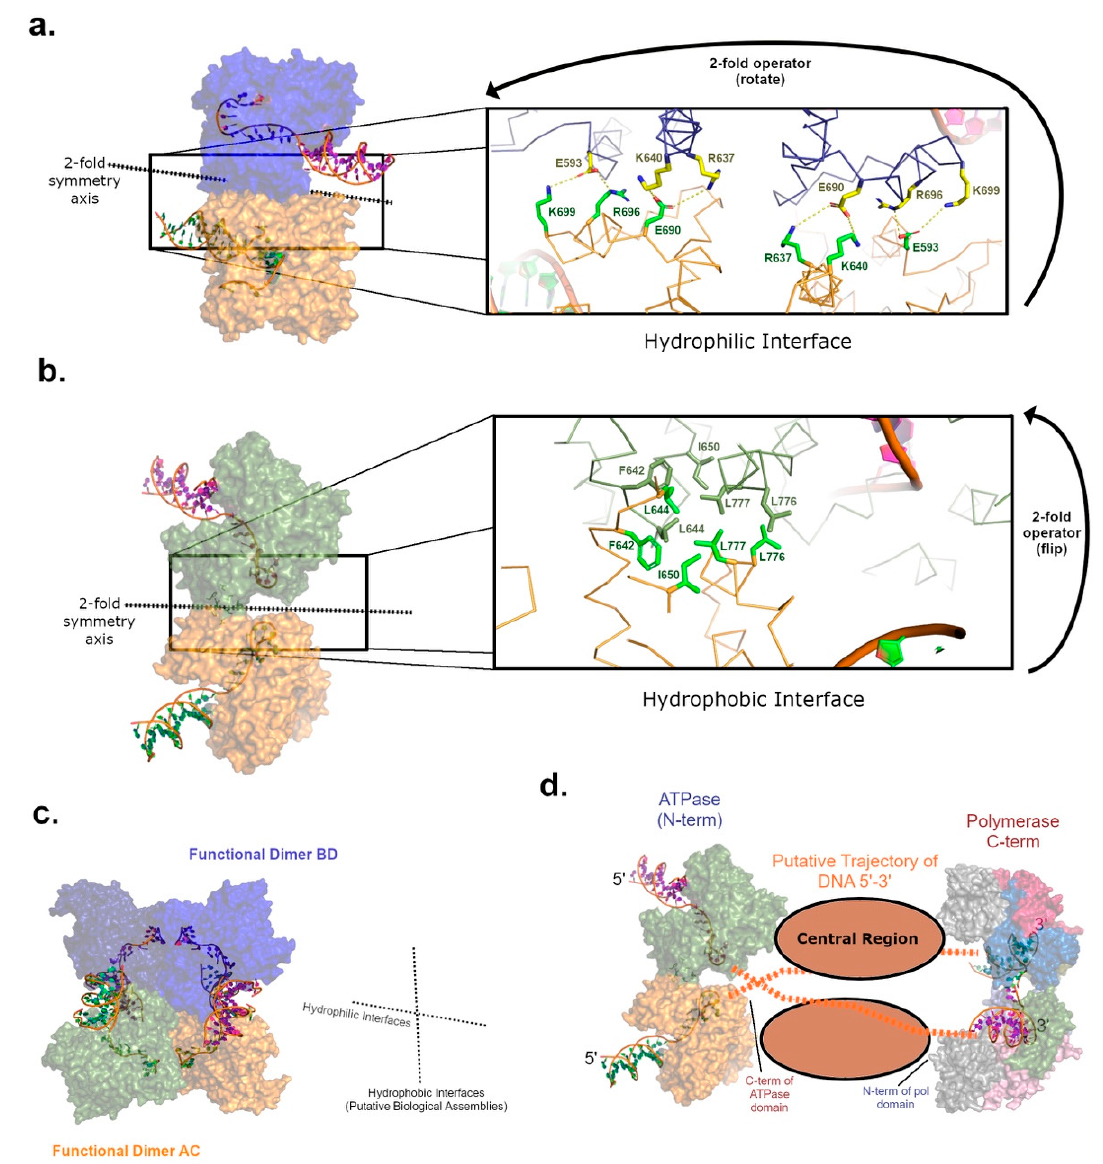
Figure 2. The pol θ ATPase and polymerase crystal structures provide dimer-of-dimers configurations (D2 symmetry) in independent structural investigations [40,53]. A homology model is generated by superimposing protein residues from the homologous structure of HEL308 (PDBID 2P6R) [51] onto the pol θ ATPase structure (PDBID 5A9J) to obtain proxy for the DNA binding mode. ( a ) One dimer interface of the overall pol θ ATPase structure is propagated by hydrophilic amino acids (brown and blue surface) with the capacity to form salt bridges. ( b ) The adjacent dimer interface is hydrophobic in character (brown and green surface) and further stabilized by a short region of antiparallel β -strands in the vicinity of F642. ( c ) Selecting the hydrophobic interface as an obligatory set of interactions defines the probable functional biological assembly (protein chains BD and AC interact via the vertical 2-fold axis represented by dashed lines). The hydrophilic interfaces (horizontal 2-fold axis) could dissociate at some point during catalysis of TMEJ or exist as an artifact of the protein truncation. ( d ) The striking compatibility of the predicted dimeric biological assemblies informed by the crystal structures of the pol θ ATPase and polymerase domains infers that 3 (cid:48) -overhanging DNA could traverse dimers of pol θ full-length from 5 (cid:48) to 3 (cid:48) , starting at the N-terminal ATPase domain and running towards the C-terminal polymerase domain (PDBID 2X0P). The DNA could pass from the ATPase domain of one pol θ molecule to the pol domain of the other (as shown), without occluding the predicted location of the central